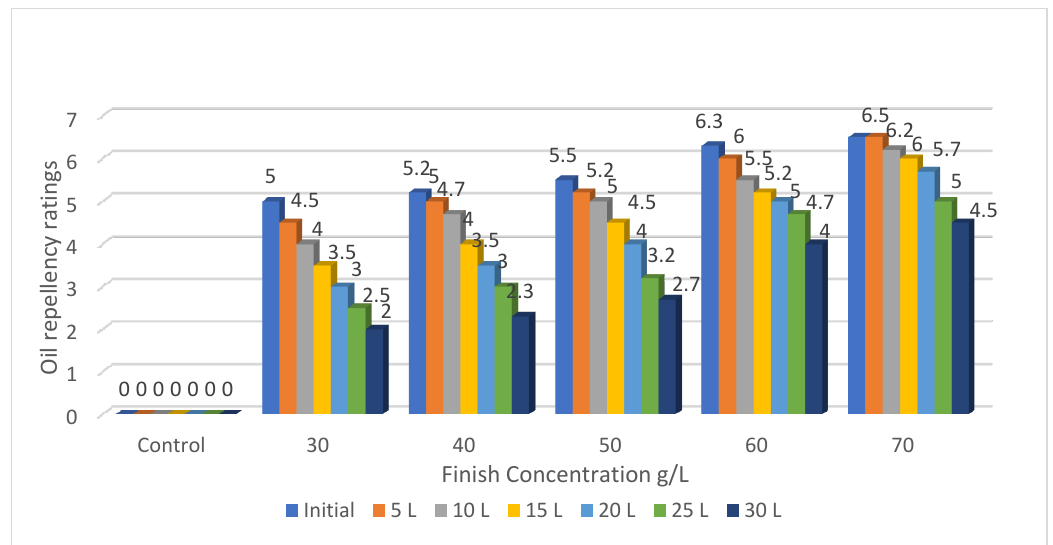
Figure 3. Effect of laundering on oil repellency (drop test) of polyester/cotton. Figure 3. E ff ect of laundering on oil repellency (drop test) of polyester /